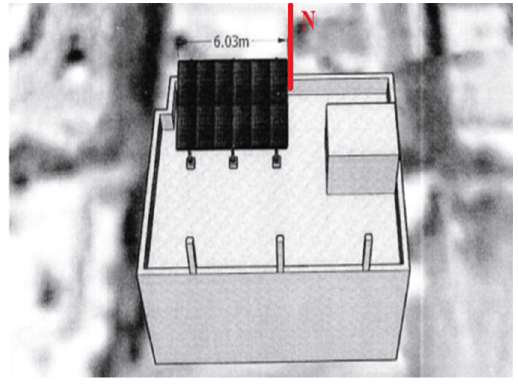
Figure 2. 3D Sketch for the photo-voltaic (PV) panel. Table 1. Parameters of the PV system.